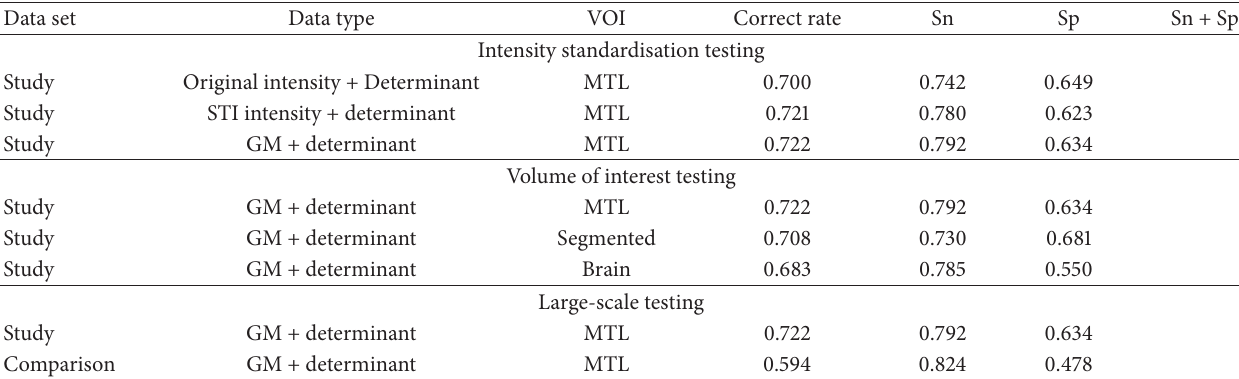
Table 3: Discrimination controls versus MCI progressors.